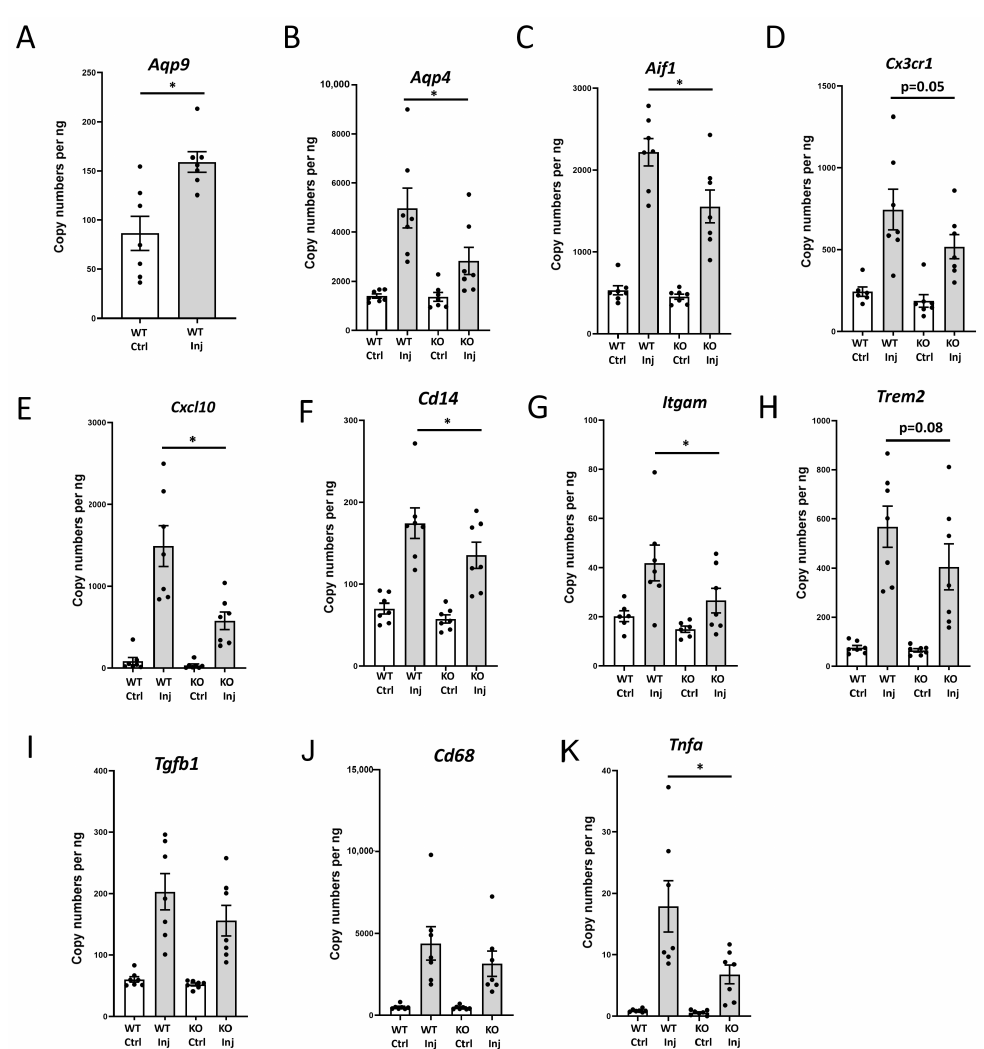
Figure 1. Changes in the RNA levels of Aqp9 and proinflammatory genes in the ipsilateral midbrain (Inj) compared with the control side (Ctrl) following unilateral intrastriatal injection of MPP + in WT and Aqp9 − / − (KO) mice. ( A ) Aqp9 expression is significantly increased in the midbrain of the injected side ( B – K ) Several inflammatory genes are upregulated in the ipsilateral midbrains of WT animals after MPP + injection compared with the control side, but the upregulation is significantly lower in the midbrains ipsilateral to the injection of the Aqp9 − / − mice. These genes include Aqp4 ( B ) which is expressed in astrocytes, and the microglial membrane proteins Aif1 ( C ), C3xcr1 ( D ), Cd14 ( F ), and Itgam ( G ), and the inflammatory cytokines Cxcl10 ( E ) and Tnfa ( K ). Transcript levels of the microglial genes Trem2 ( H ) and Cd68 ( J ) and the cytokine Tgfb1 ( I ) were not significantly different in the injected hemisphere of the two genotypes. Bars are mean ± 2SEM, * p <